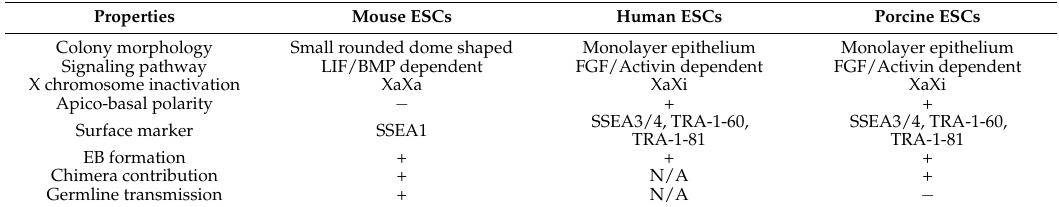
Table 1. Characteristic comparison of mouse ESCs, human ESCs, and porcine